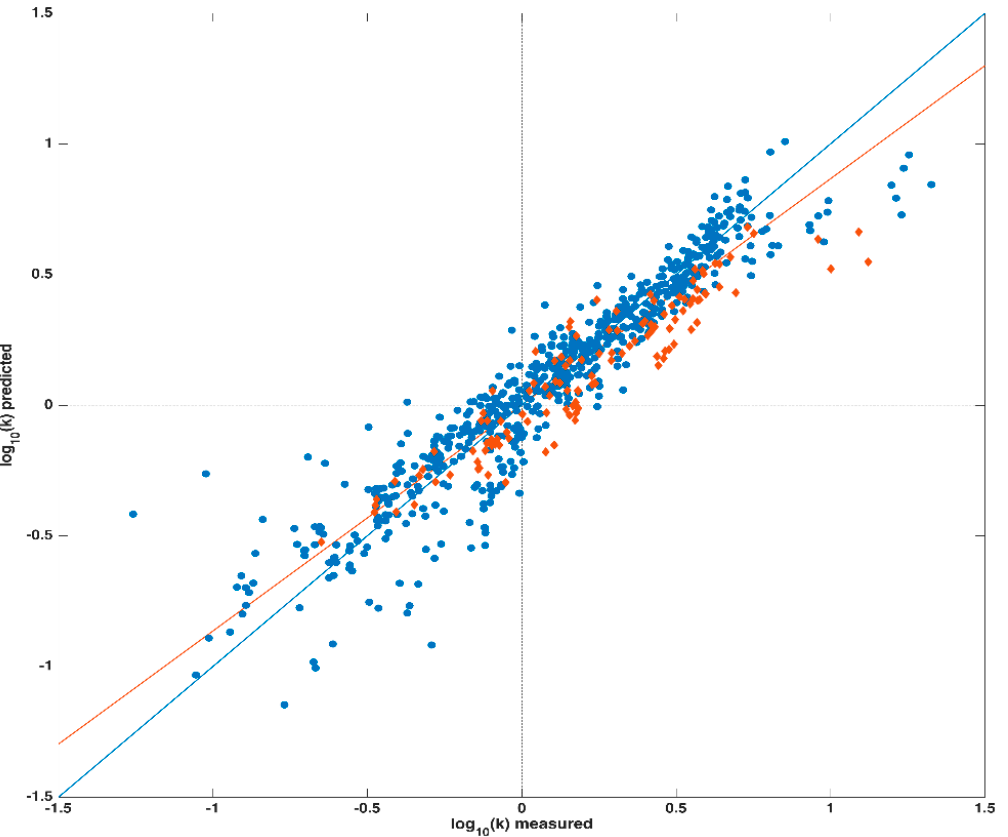
Figure 1. PLS model. Legend: Calibration set: blue dots; Test set: orange diamonds.